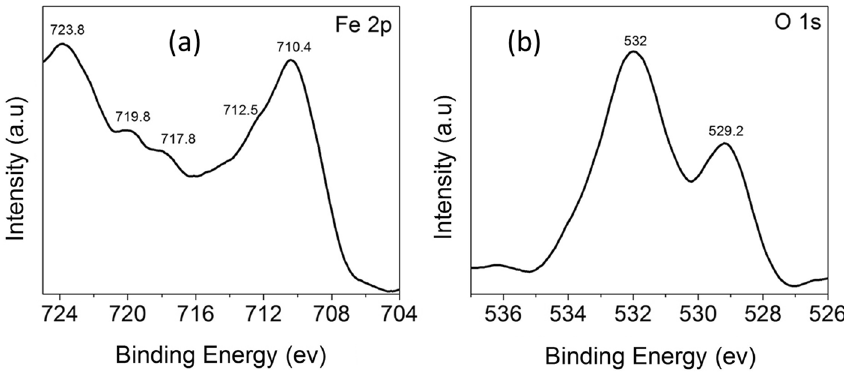
Figure 8. High-Resolution XPS spectra of ( a ) Ti 2p and ( b ) O1s of α-Fe 2 O 3 .